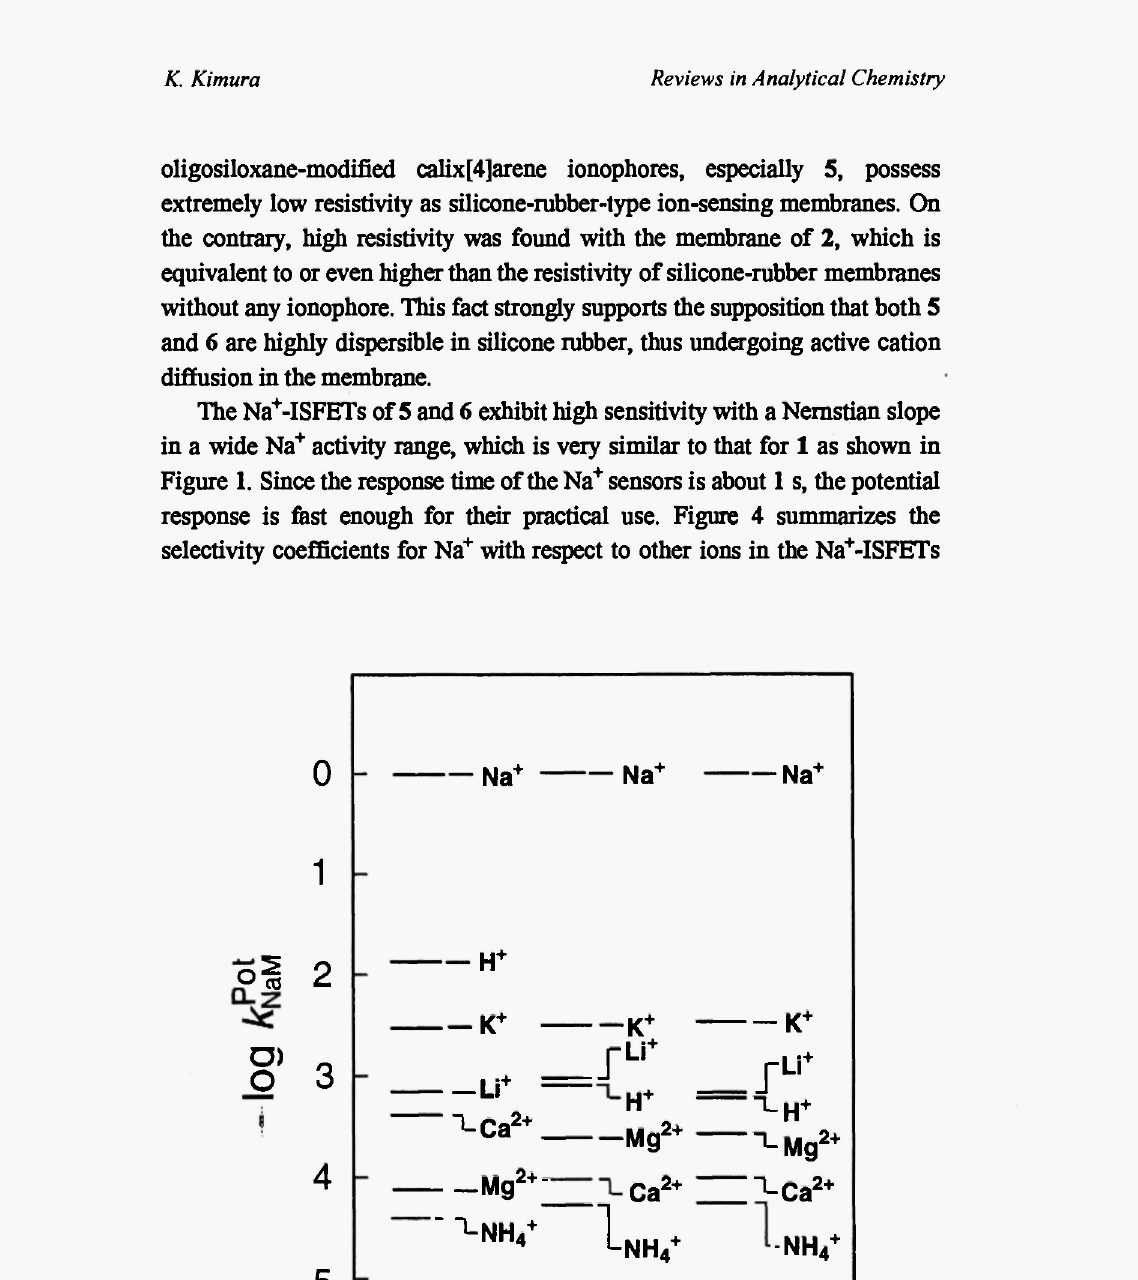
Fig. 4: Selectivity comparison between silicone-rubber membranes Na + -ISFETs based on calixarene ionophores 1,2, and 5